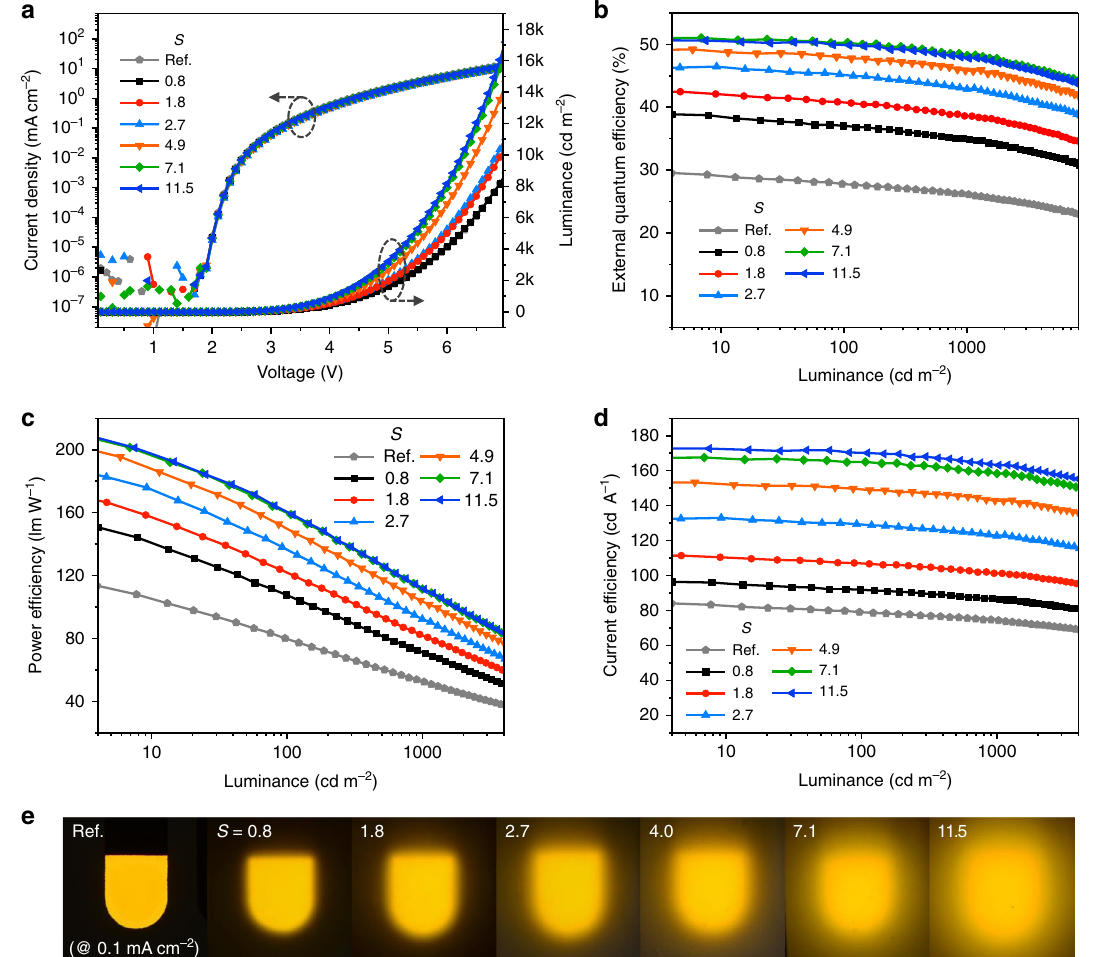
Fig. 3 Characteristics of organic light-emitting diodes (OLEDs) with SiO 2 -based scattering layers. a Current density ( J ) − luminance ( L ) − voltage ( V ) characteristics. b − d External quantum ef fi ciency ( b ), power ef fi ciency ( c ), and current ef fi ciency ( d ) vs. L . Layout of the devices used in this fi gure follows that of Type A de fi ned in Fig. 4b. e Photographs of OLEDs with SiO 2 -embedded scattering layers according to scatterance ( S ). Photographs were taken at current density of 0.1 mA cm −